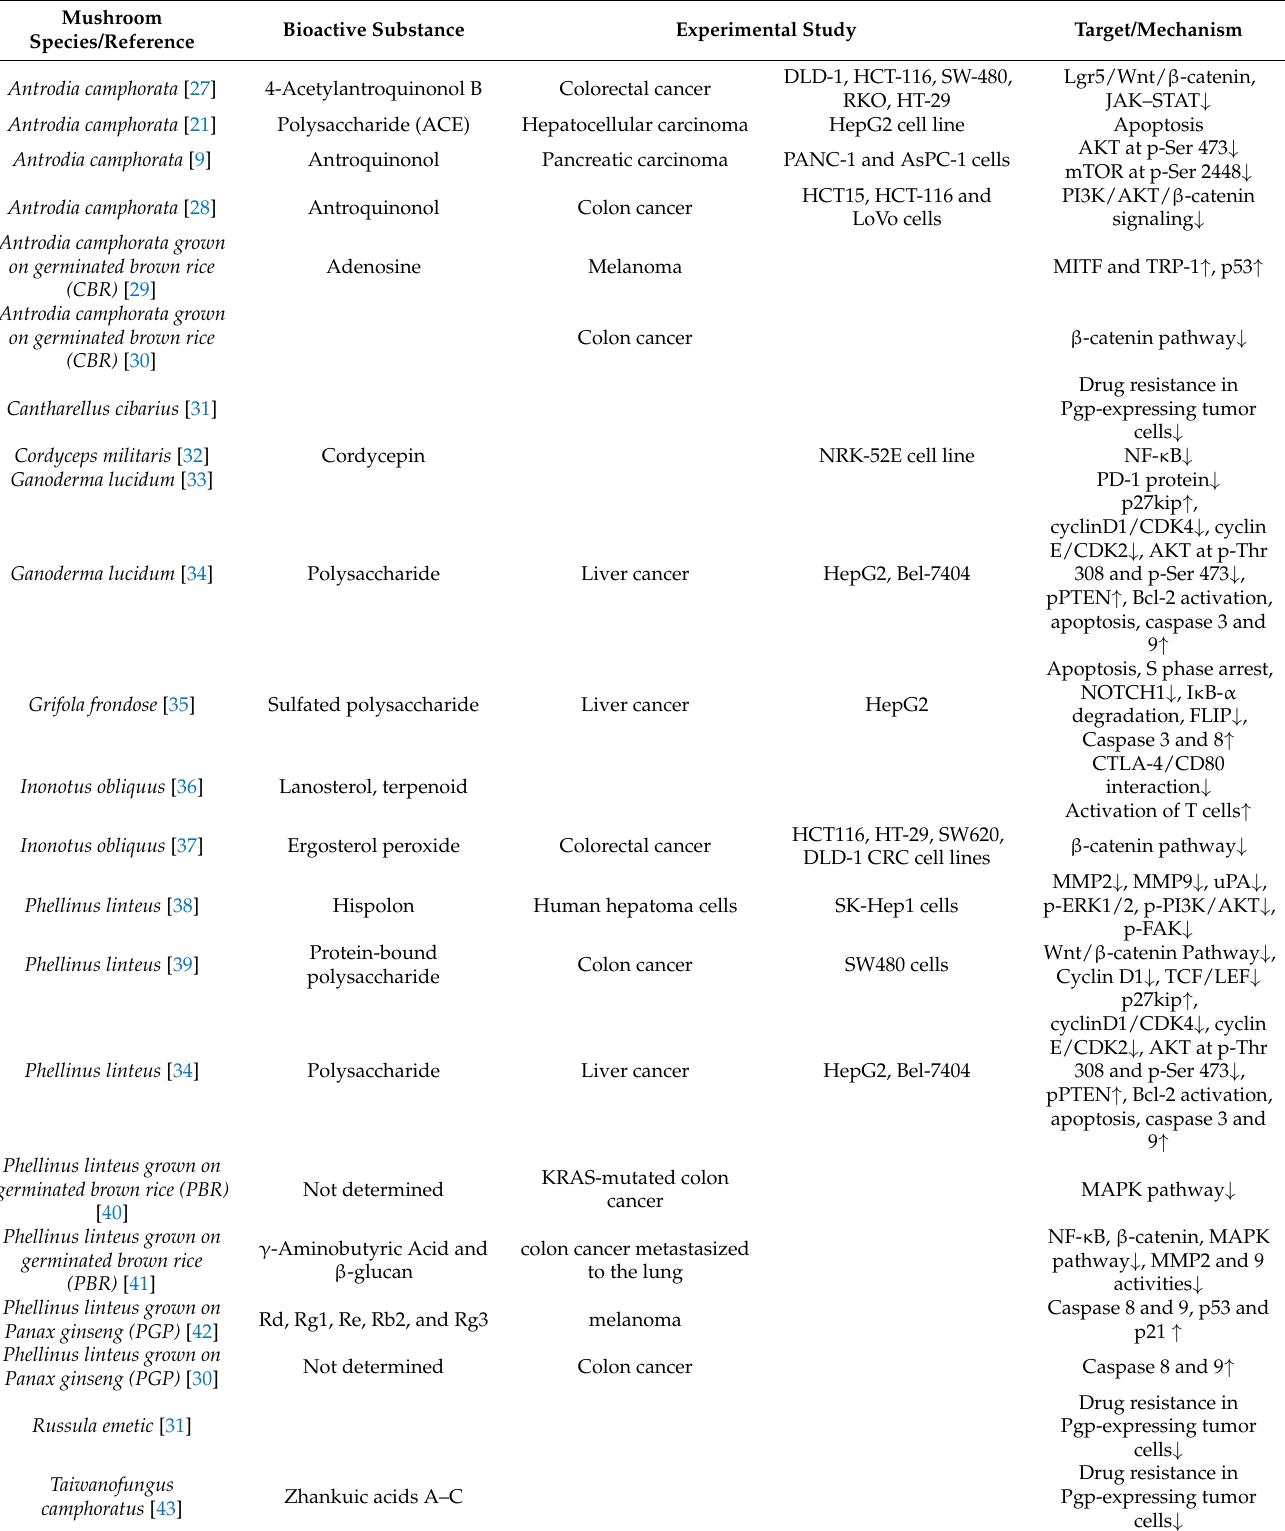
Table 2. Anticancer mechanisms of mushrooms and their bioactive